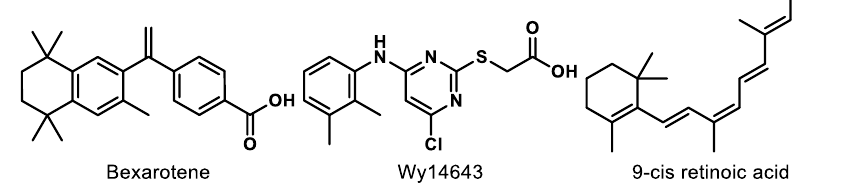
Figure 9. Compounds mentioned for dual PPAR–RXR interaction.